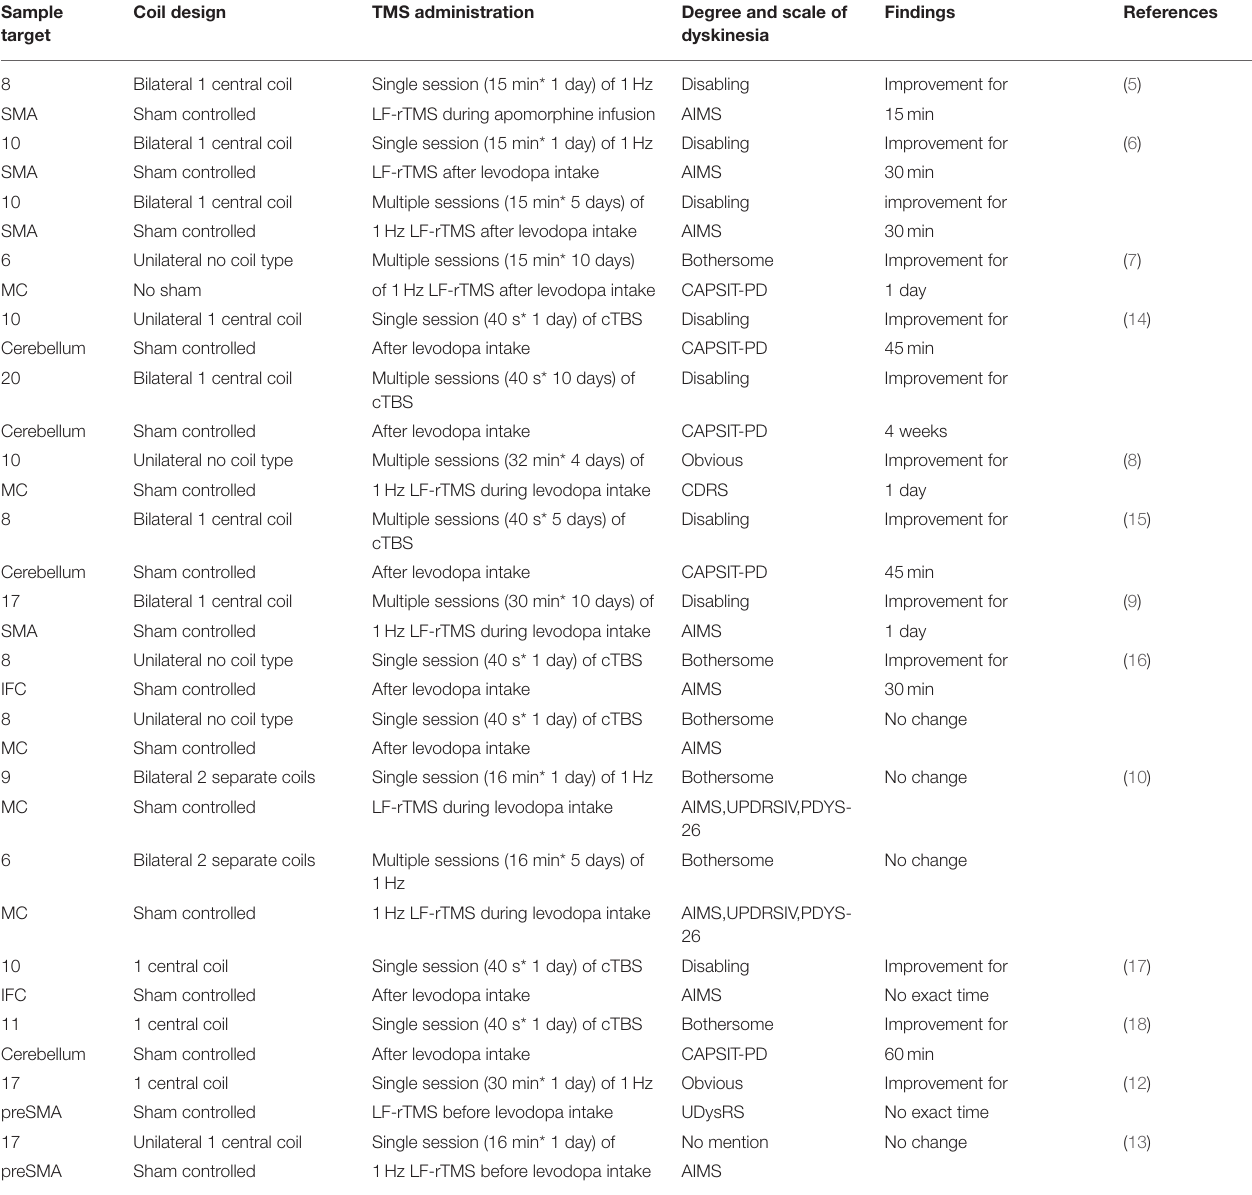
TABLE 1 | Overview of inhibitory TMS (LF rTMS/cTBS) for the treatment of LID in PD. Sample